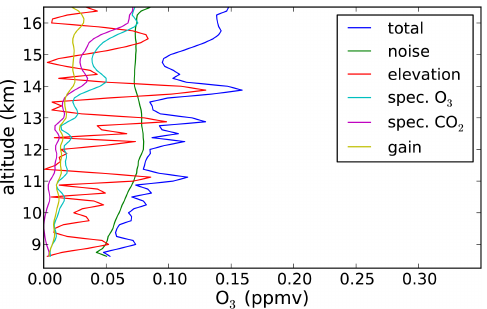
Figure 9. Error budget for O 3 for GLORIA Image 72.